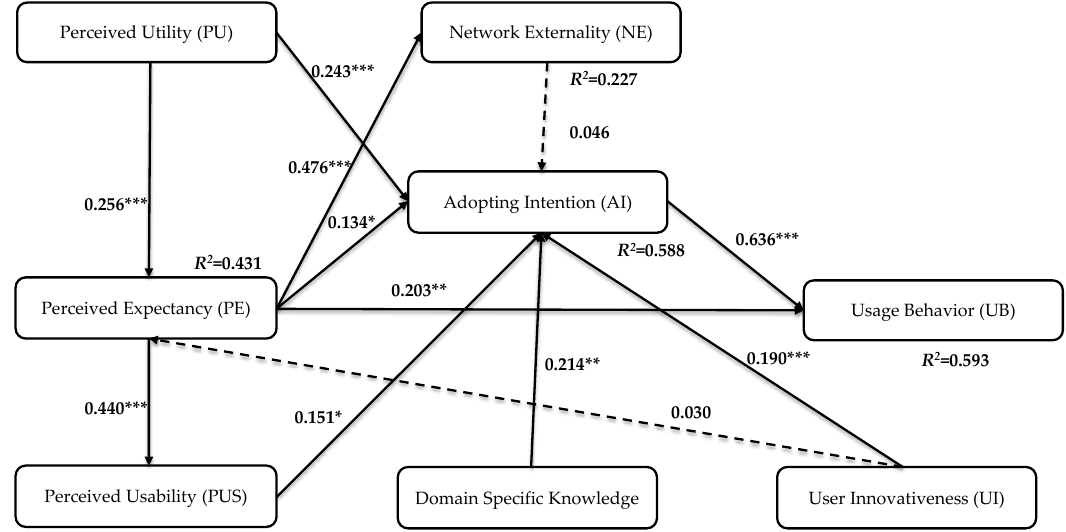
Figure 4. Structural model of IoT-based wearable fitness trackers adoption with path coefficients. Note: *** p < 0.001, ** p < 0.01, * p <